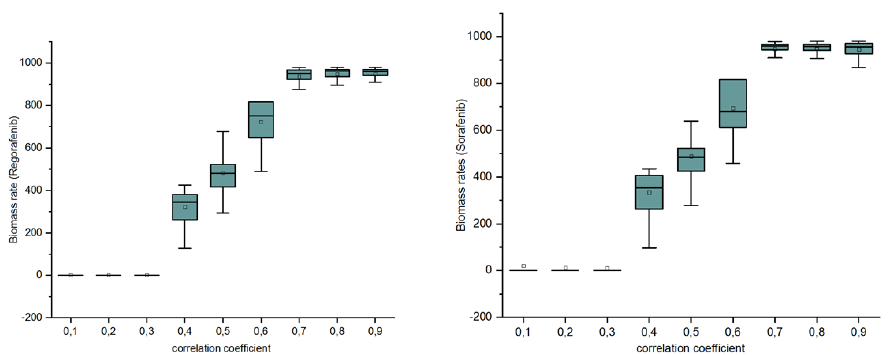
Figure 7. Distribution of biomass rates in terms of the cutoff value of Pearson’s correlation coefficient: For each simulation, we selected genes that have correlation coefficients above a fixed cutoff. For 0.1, 0.2, and 0.3 thresholds, the average of biomass rates predicted by BayRegNet for each drugs is (cid:39) 0. This is due to the fact that an important number of genes have been selected and that consequently all their corresponding TFs are knocked out, which inhibits cell growth. From the shape of the biomass distribution with respect to the threshold values, we can see that a cutoff value of 0.5 is a convenient threshold in our